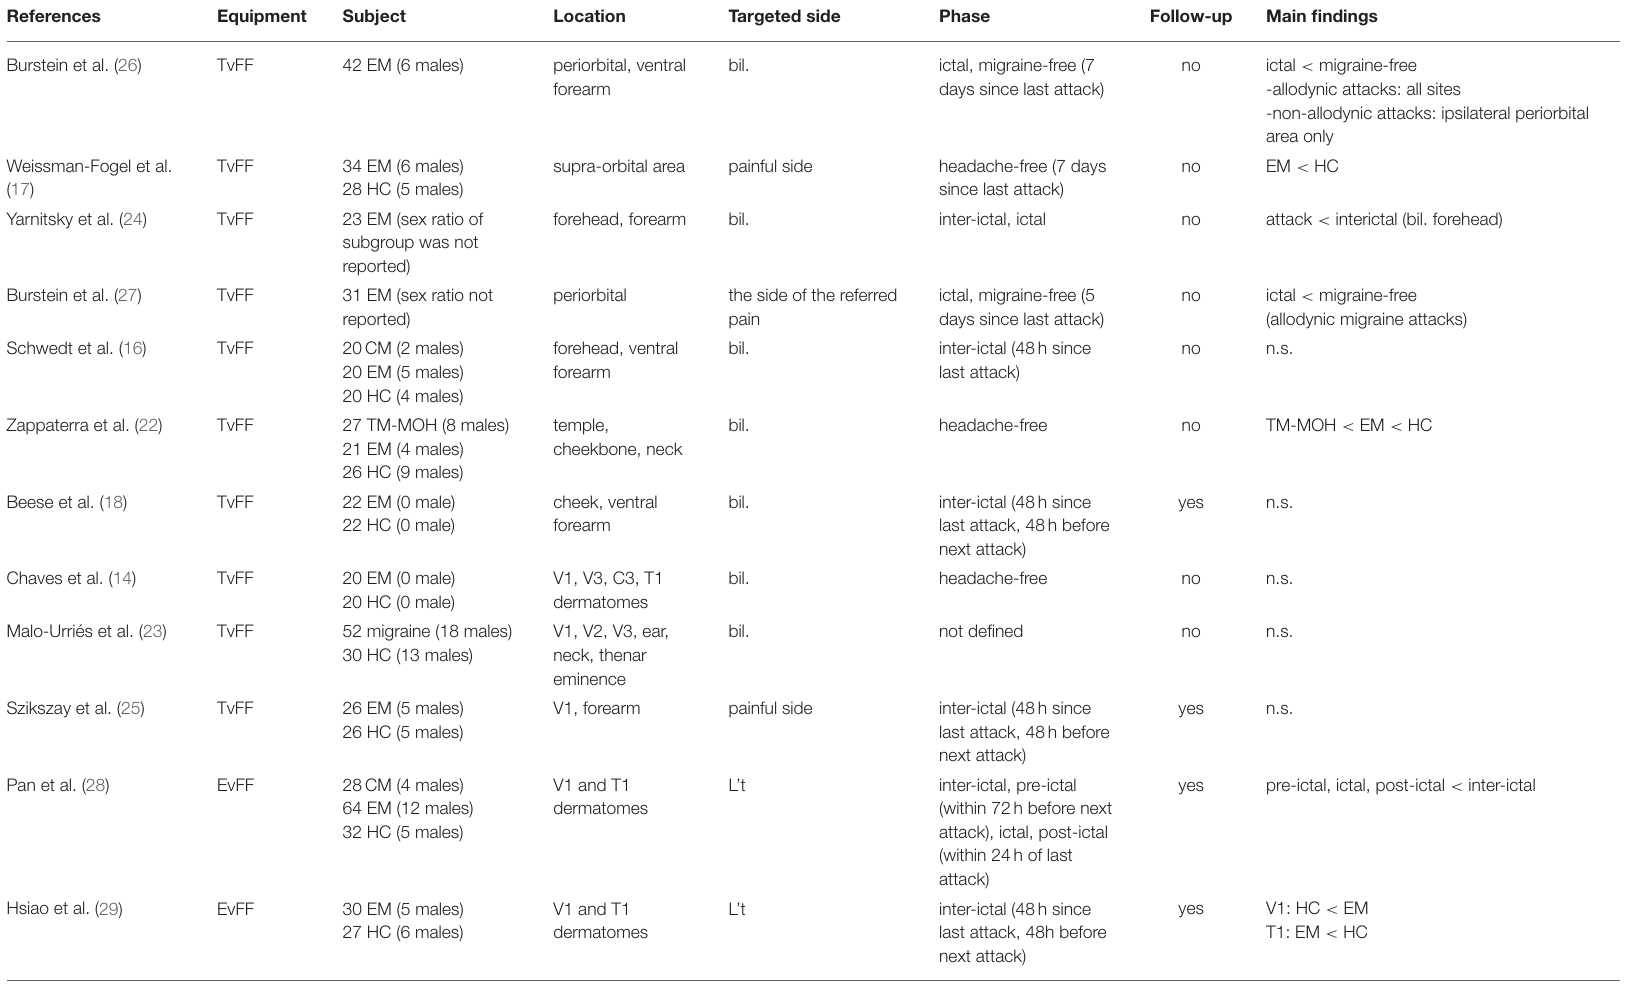
TABLE 1 | Studies included in the